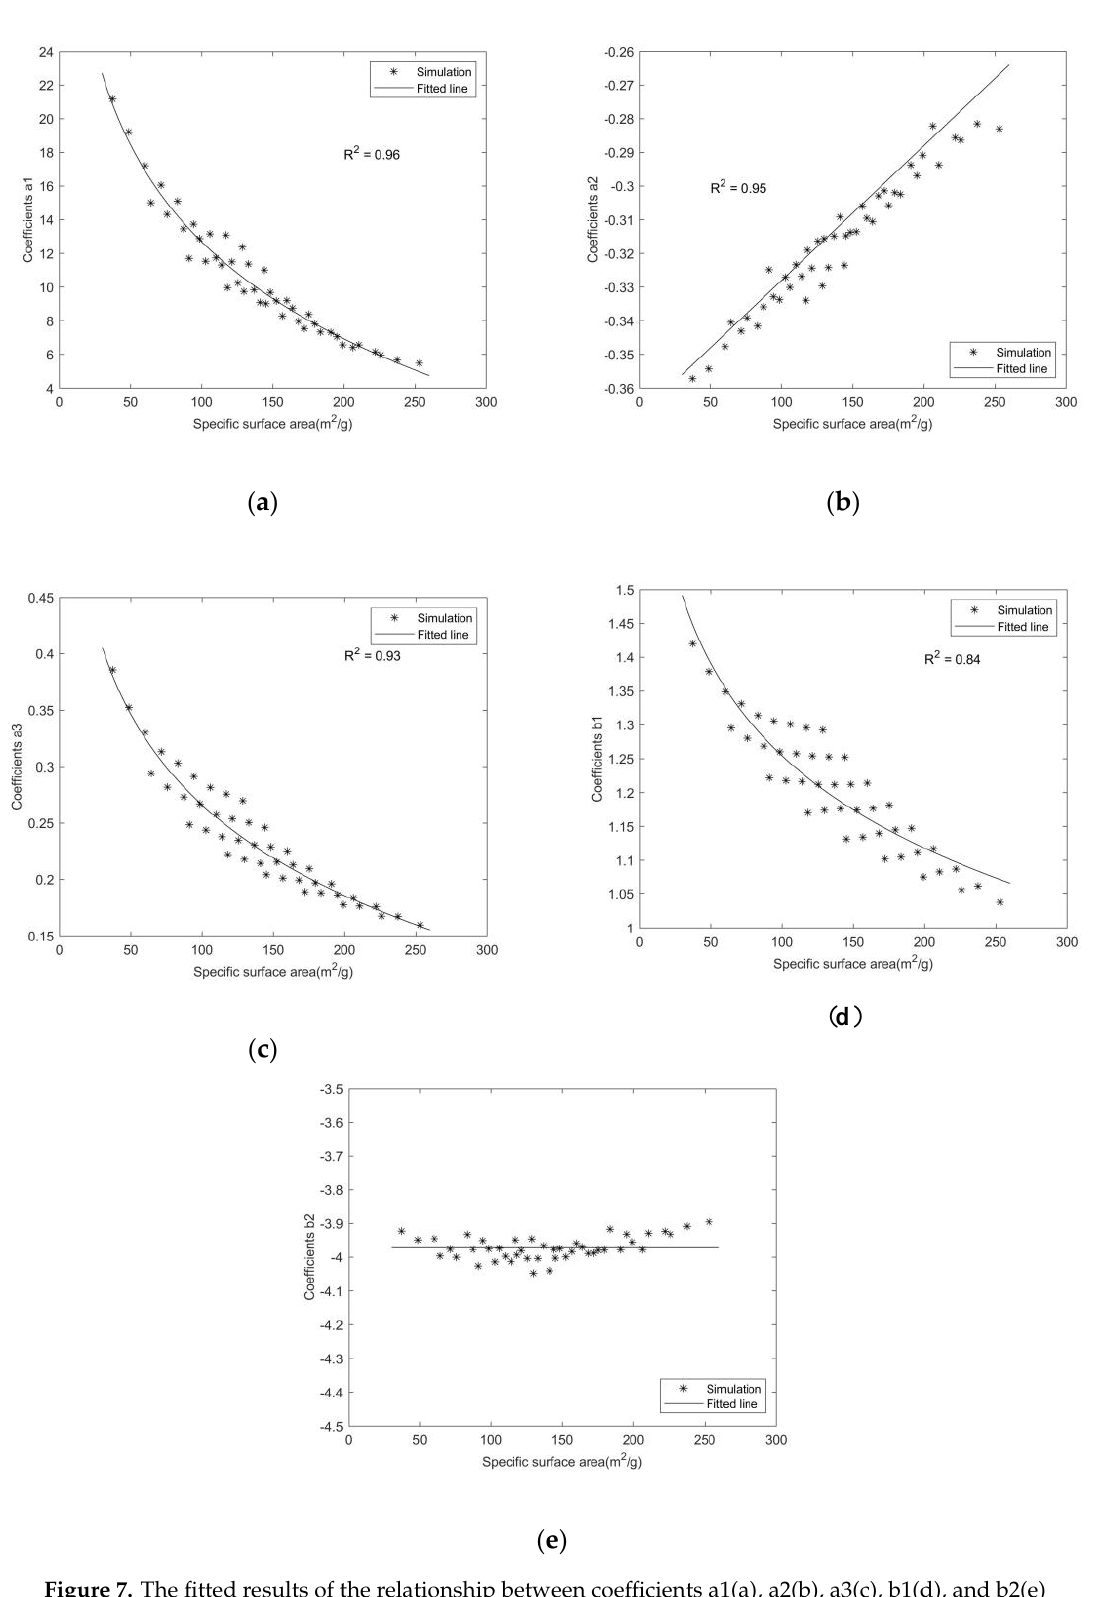
( b ) Figure 6. The fitted results of the relationship between coefficients A( a ) and B( b ) and frequency. According to the fitted results, the coefficient A and B is negatively and positively correlated with frequency, respectively. They can be expressed by a function of frequency as: A = a 1 e a 2 f + a 3 B = b 1 + b 2 /f ,